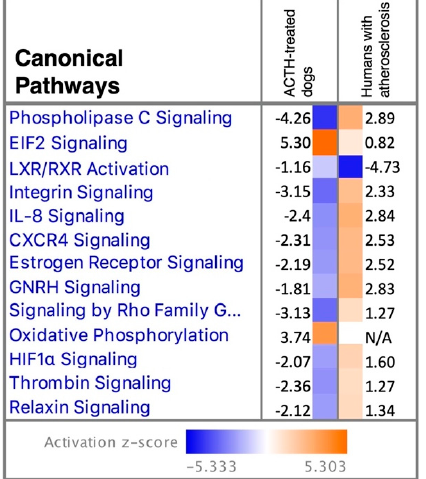
Figure 6. Main selected canonical pathways enriched in visceral adipose tissue (VAT) of ACTH-treated dogs detected in the present study and of humans presenting with atherosclerosis. The analysis match feature from the IPA software was used to compare enriched pathways in the transcriptome of VAT of dogs treated with ACTH (induced Cushing’s syndrome) with enriched pathways in the microarray of VAT of humans presenting with atherosclerosis [30]. Presented pathways were ranked according to Z -score. The predicted activity pattern of each given pathway is indicated by color (as defined in figure legend) and follows the calculated Z -score (positive Z -score indicates activation while negative Z -score relates to predicted deactivation of canonical pathway). Generally, an inverse predicted behavior of presented pathways was observed between the compared